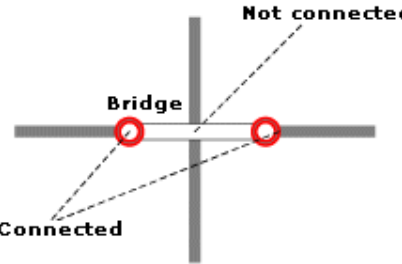
Figure 1. Network connectivity (Understanding connectivity,